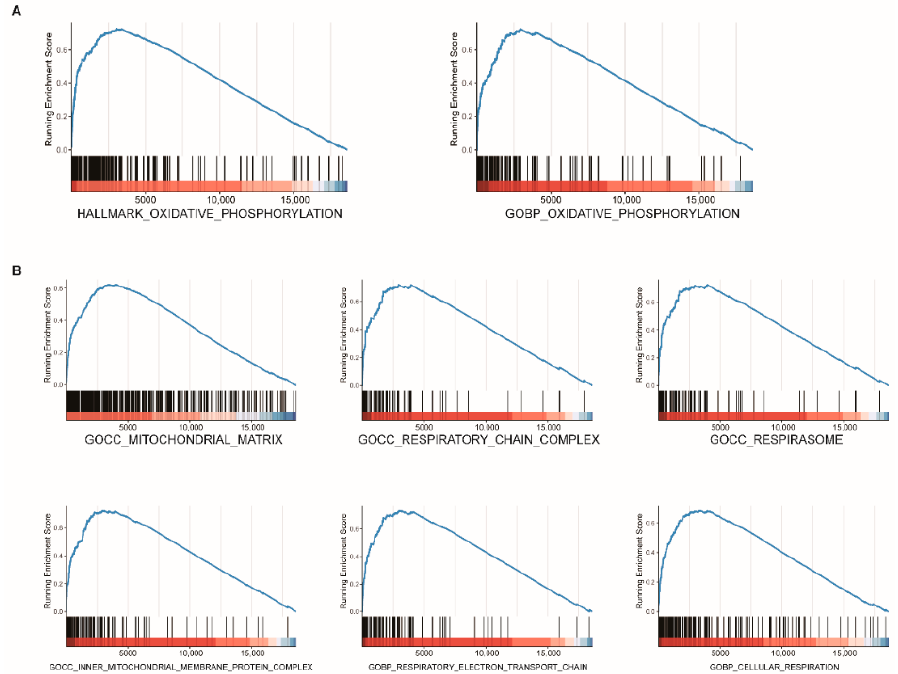
Figure 7. Functional enrichment analysis of FDX1 in ccRCC. GSEA plot reveals that FDX1 mainly participated in oxidative-related processes ( A ) and mitochondrial respiration-related processes ( B ).